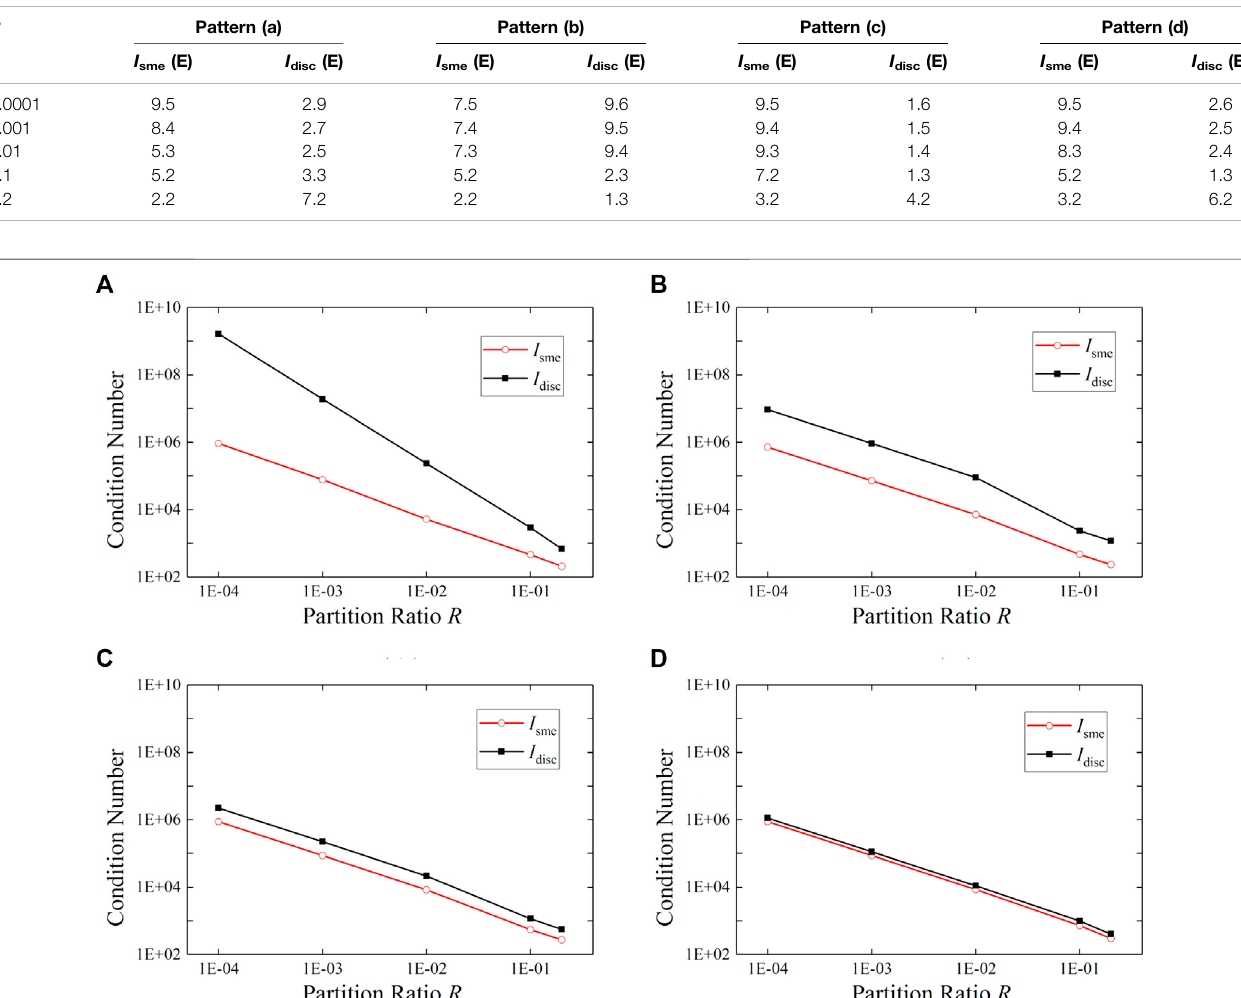
Frontiers in Earth Science |